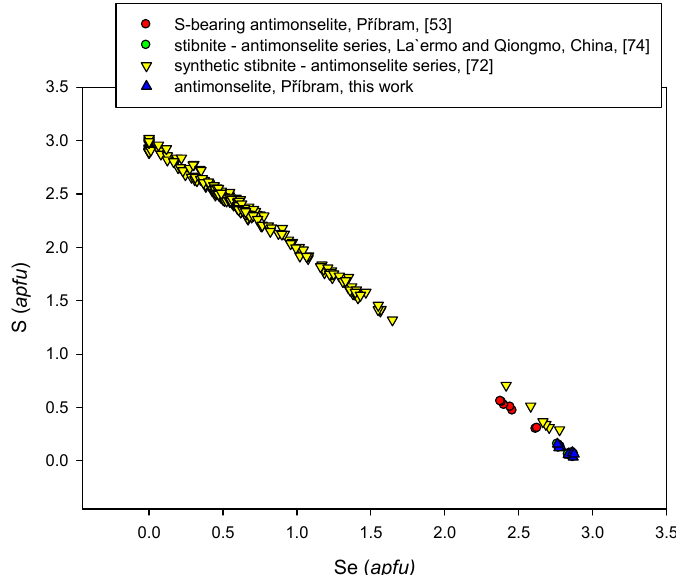
Figure 6. Se vs. S ( apfu ) graph of antimonselite from various localities.